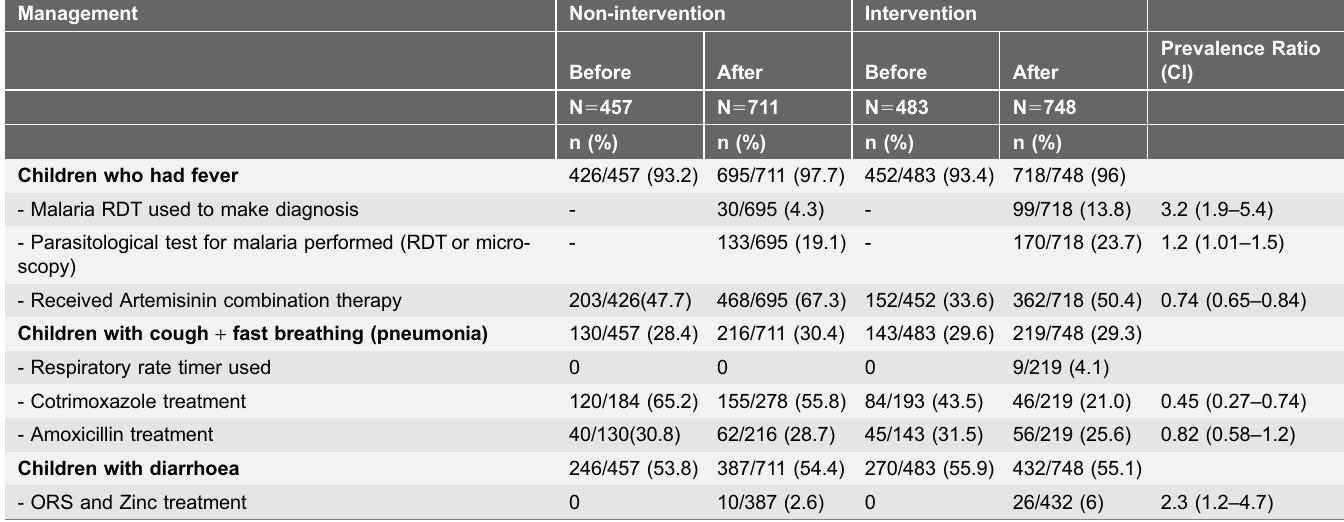
Table 5. Survey adjusted appropriateness of management of illness within the last 2 weeks, from household survey.